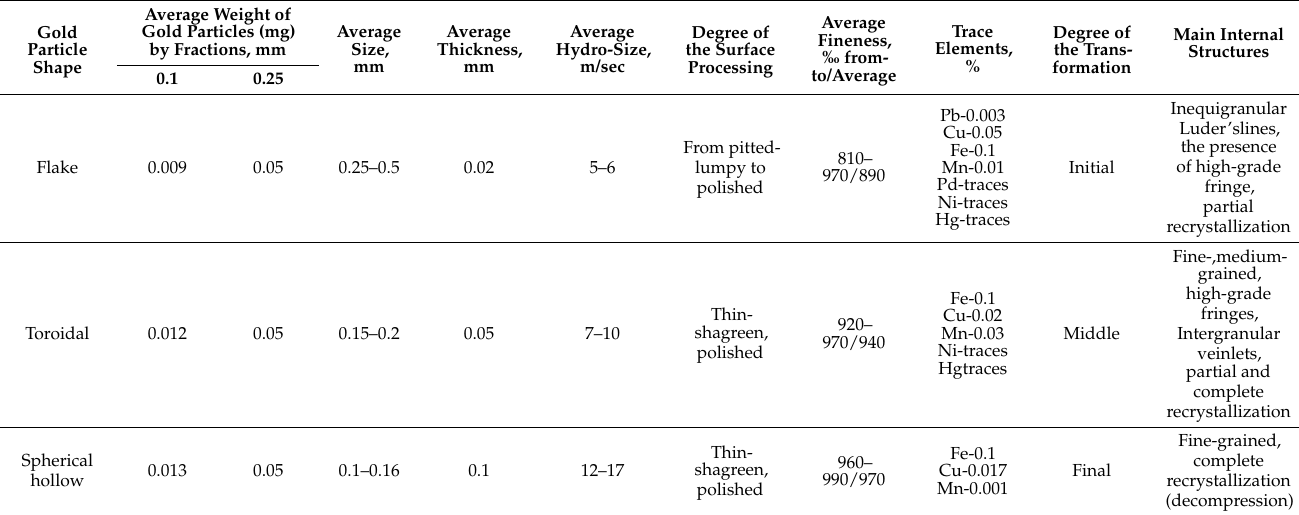
Table 1. Typomorphic features of complex-deformed gold particles of the Lena–Viluy interfluve (east Siberia platform). Number of objects: